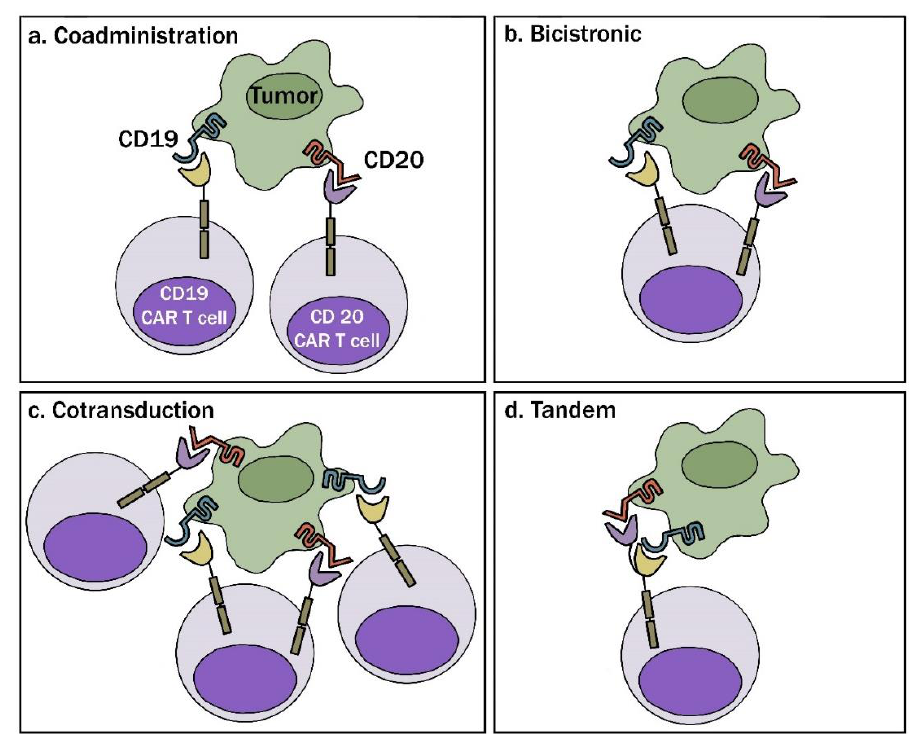
Figure 1. Dual antigen chimeric antigen receptor CAR T approaches. ( a ) Coadministration: involves production of two separate CAR T cell products infused together or sequentially. ( b ) Bicistronic: allows expression of two different CARs on the same cell. ( c ) Cotransduction: encodes two CAR constructs with multiple vectors. With this process, one will also obtain cells that express each CAR alone. ( d ) Tandem: encodes two CARs on same chimeric protein using a single vector. This work is